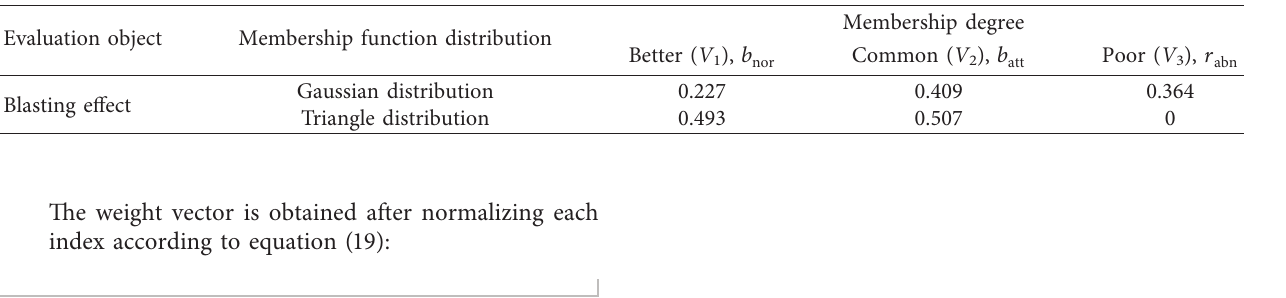
Figure 10: Vibration velocity of the monitoring point by numerical simulation. (a) X -direction vibration of the monitoring point by numerical simulation. (b) Y -direction vibration of the monitoring point by numerical simulation. (c) Z -direction vibration of the monitoring point by numerical simulation. Table 5: Comparison of fuzzy comprehensive